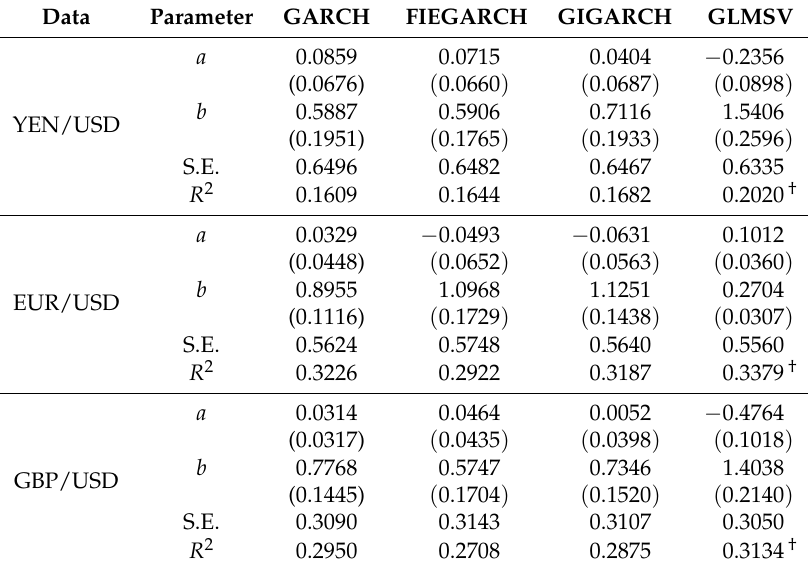
Table 6. Results for MZ